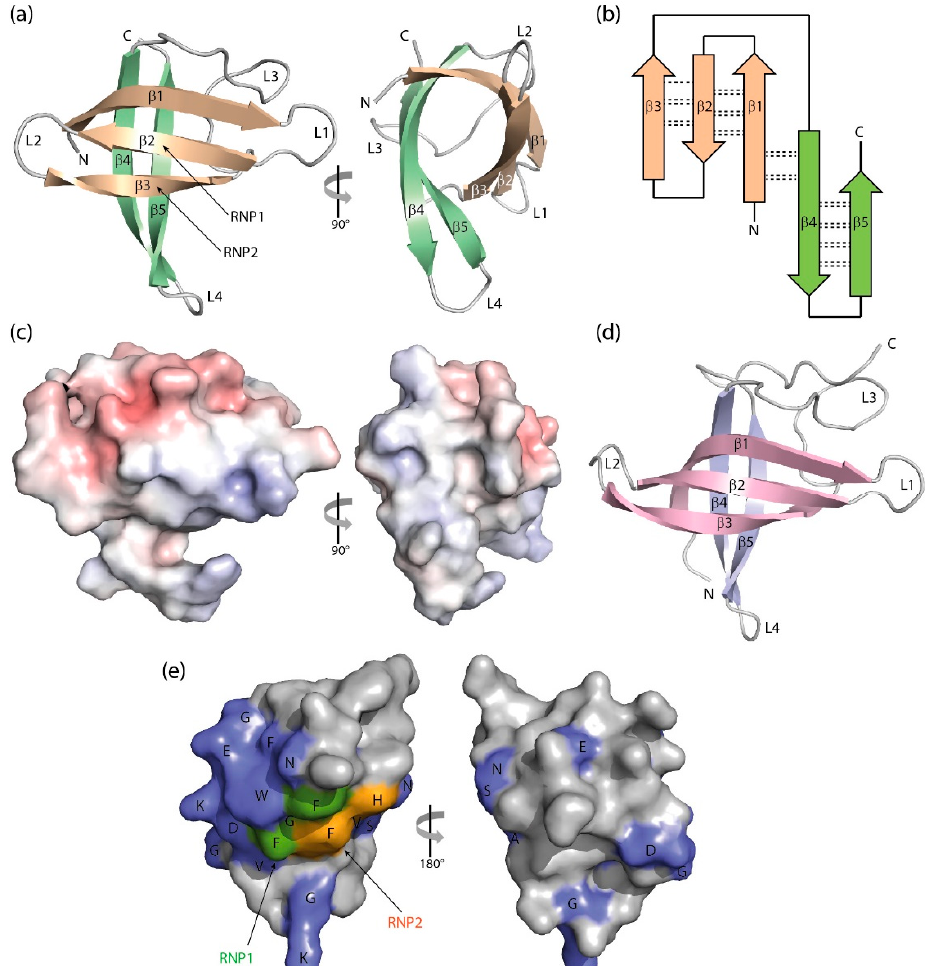
Figure 3. Three-dimensional structure of cold-shock proteins and domains determined at near-atomic resolution. ( a ) Cartoon drawing, ( b ) topology diagram with β -sheet stabilizing hydrogen bonds, and ( c ) electrostatic surface potential colored from red ( − 10 kT/e) to blue (+10 kT/e) of Bc CspB (PDB entry 1c9o). ( d ) Schematic drawing of the X. tropicalis LIN28 CSD (PDB entry 3ulj). Orthogonal views are presented in ( a , c ). ( e ) Conserved residues on the surface of St CspE (PDB entry 3i2z). RNP1/RNP2, RNA-binding motifs [20]. Note the close structural similarity between the bacterial Bc CspB [97] and the eukaryotic LIN28B CSD [100], the separation of negative (red) and positive (blue) surface charge in ( c ) and the asymmetric distribution of conserved residues over the CSP surface. Cartoon drawings were prepared with PyMOL [101], the topology diagram is based on PDBsum [102], and the electrostatic surface was calculated with the Adaptive Poisson-Boltzmann Solver (APBS) plugin [103] of PyMOL.